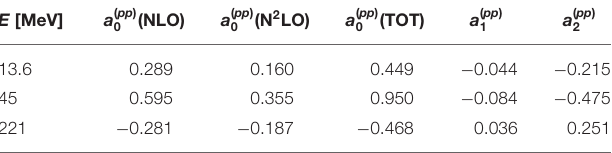
TABLE 5 | Values of the coefficients a ( pp ) i calculated with the χ EFT N 2 LO PVTC potential described in section 3.4 and the N 4 LO PCTC potential derived in Entem et al. [18] at three energies corresponding to the experimental data points.